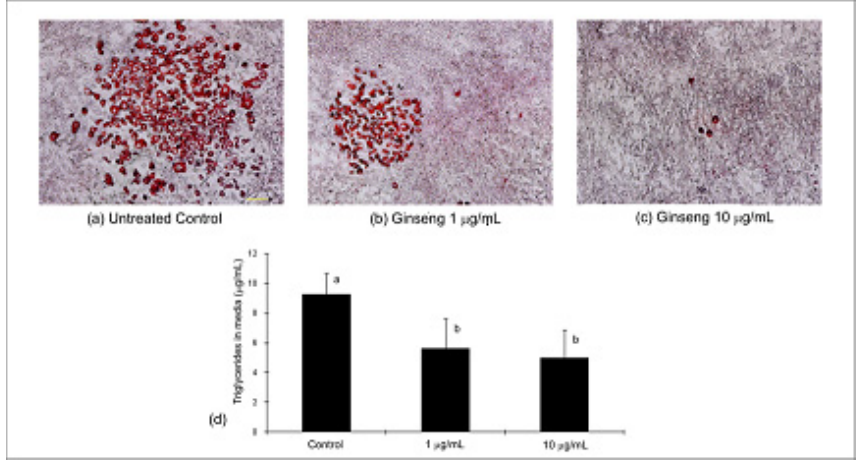
Figure 5 . Representative morphological images of lipid uptake in untreated (panel a) and ginseng treated 3T3-L1 cells (panels b, c) and the corresponding quantification of triglycerides in media (panel d). Cells were induced to differentiate as described in the Materials and Methods section. Values are expressed as mean ± SD. Bars with a different letter are significantly different ( P < 0.05) from each